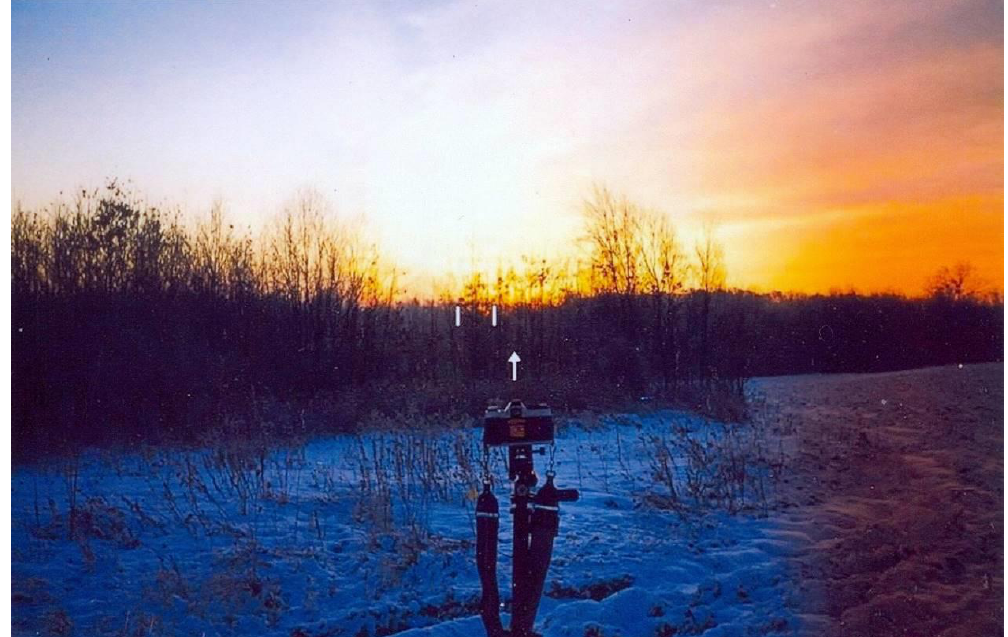
Figure 15. The winter solstice sunrise (full disk between the parallel vertical white lines) viewed from the hilltop circle. Note that the disk of the sun shifted a minimum of one full sun disk north (left) of the camera centre (and arrow) pointed along the alignment of spaced rocks and toward the large boulder (Figures 13 and 14). The effect is due to the shift of the obliquity of the ecliptic or change in the earth’s tilt over 3500-5000